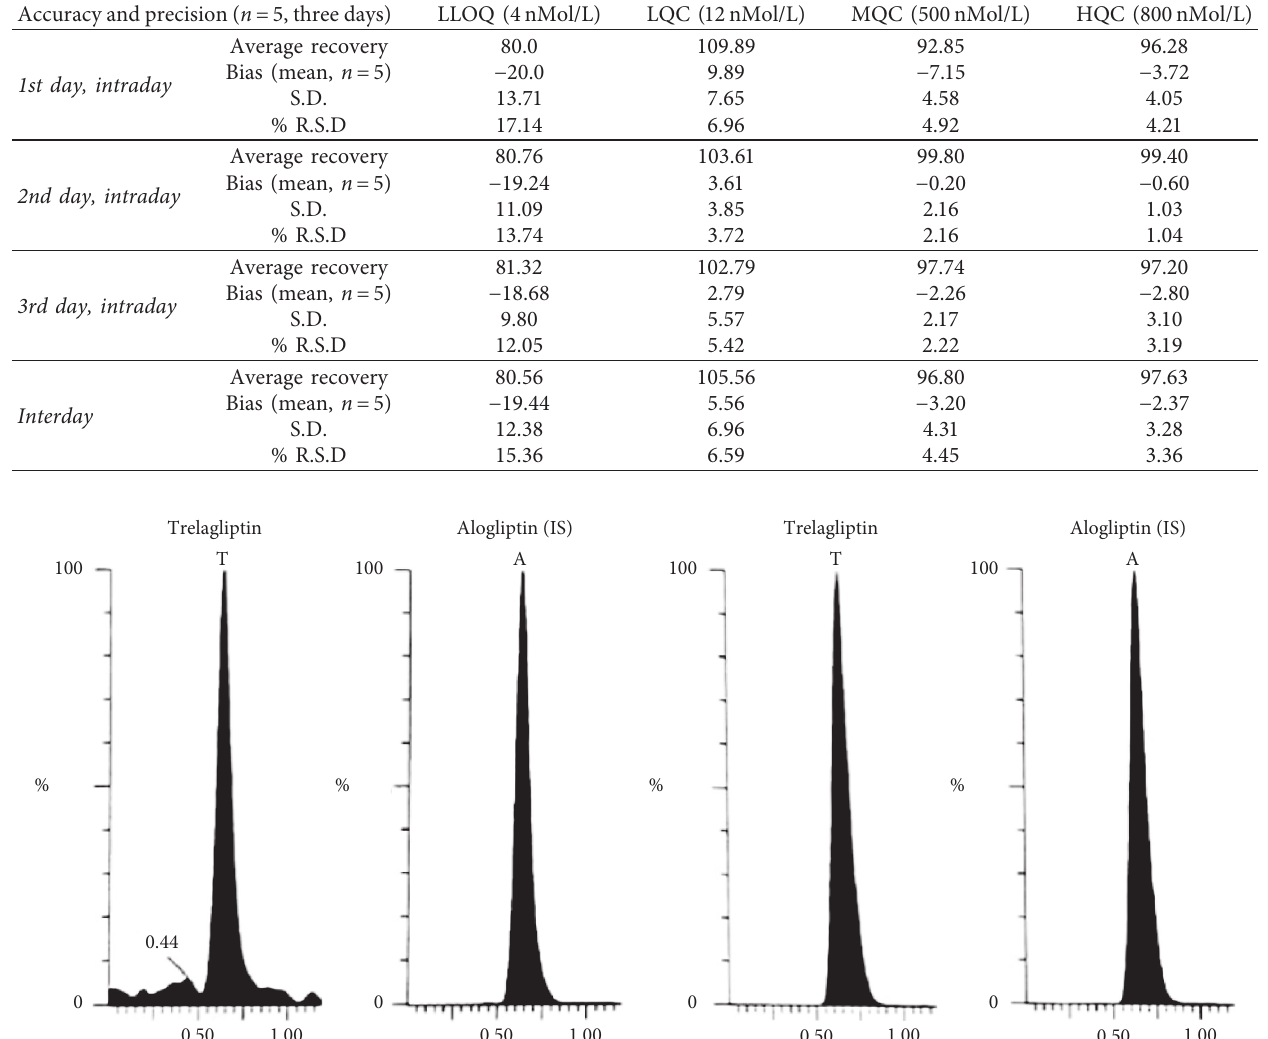
Table 1: Accuracy and precision results for TLN bioassay.